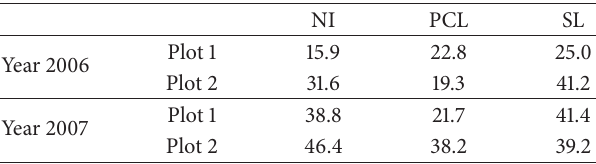
Table 3: Mean values for risk of herbivory (proportion of plants that suffered herbivory by ungulates) for years 2006 and 2007 for plants of Ulex parviflorus sampled in the experiment (one- and two-year- old plants,